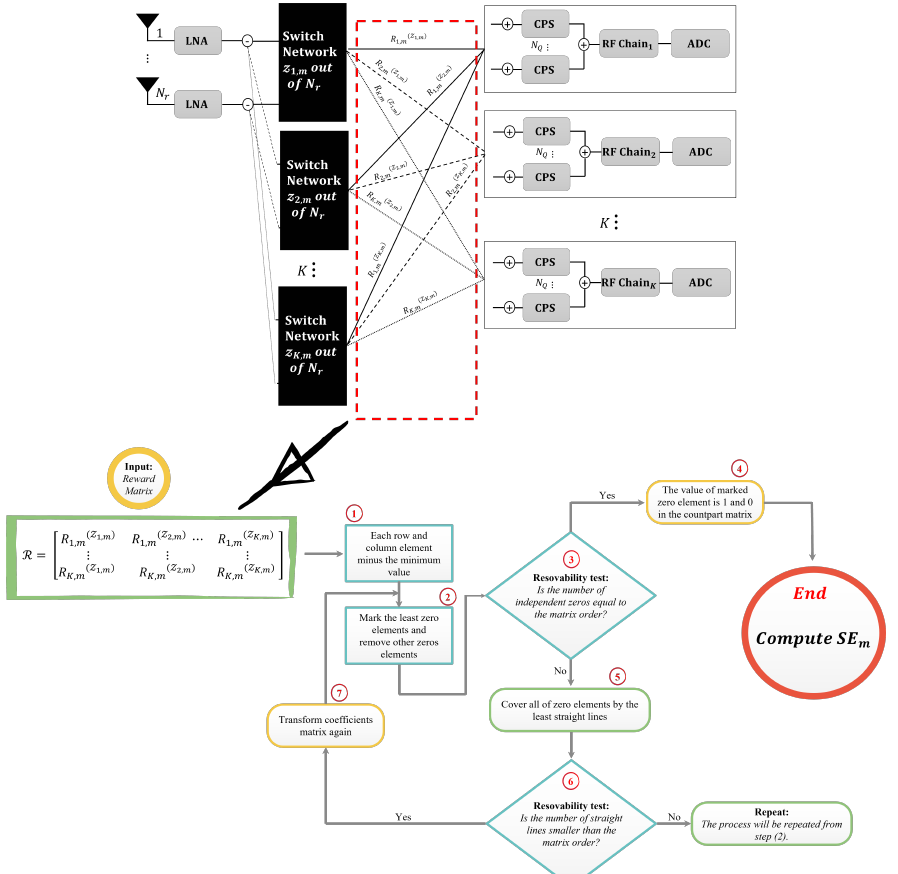
Figure 2. Proposed matching strategy for RF chain-subset selected antennas for each AP diagram with flowchart of the Hungarian